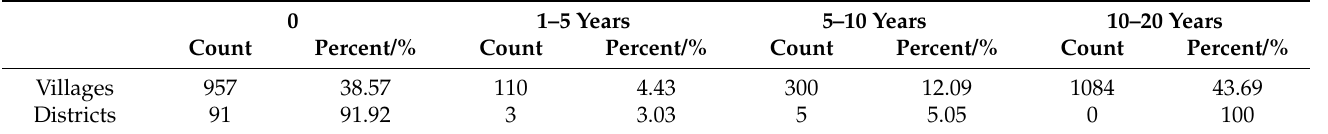
Table 4. Statistics of districts and villages stopping swidden